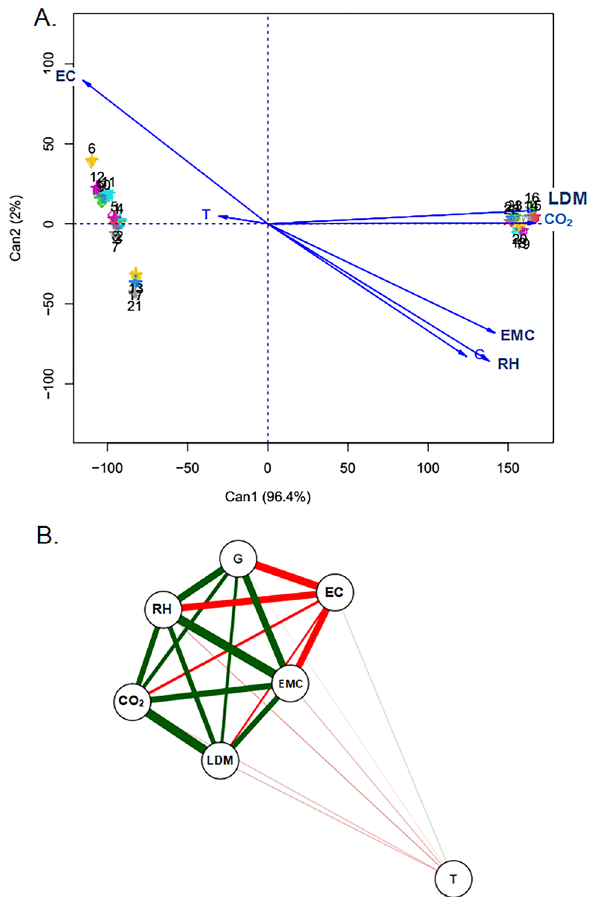
Figure 7. Analysis of the qualitative canonical variables of corn grains ( A ). Pearson correlation analysis of the qualitative variables of corn grains ( B ). Green lines link variables to positive correlation and red lines link negatively correlated variables. The thickness of the line is proportional to the correlation magnitude.